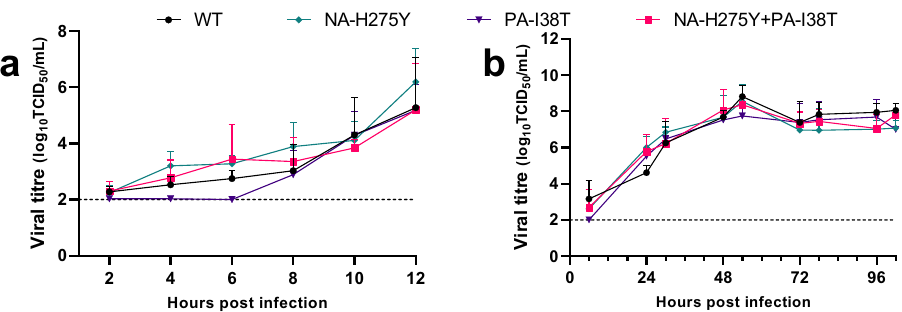
Fig. 1 Virus growth in single and multi-stage replication cycles. MDCK cells were infected with virus isolates containing one or both NA-H275Y and PA- I38T mutations. a Single-stage replication assay (MOI 5) with sampling every 2 h for a total of 12 h. b Multi-stage replication assay (MOI 0.01) and sampled at 6, 24, 30, 48, 54, 72, 78, 96, 102 h. Infectious virus in the supernatant was quanti fi ed by TCID 50 . Each symbol represents the mean amount of virus present at each time point and the error bars depict one standard deviation (SD). Data in each graph is the combination of three independently conducted experiments performed in triplicate. Limit of detection (LOD) is shown as a dotted horizontal line, all values below LOD equal two log 10 TCID 50 / mL. No statistically signi fi cant differences (adjusted p < 0.05) were observed (Two-way ANOVA with Sidak ’ s multiple comparisons).